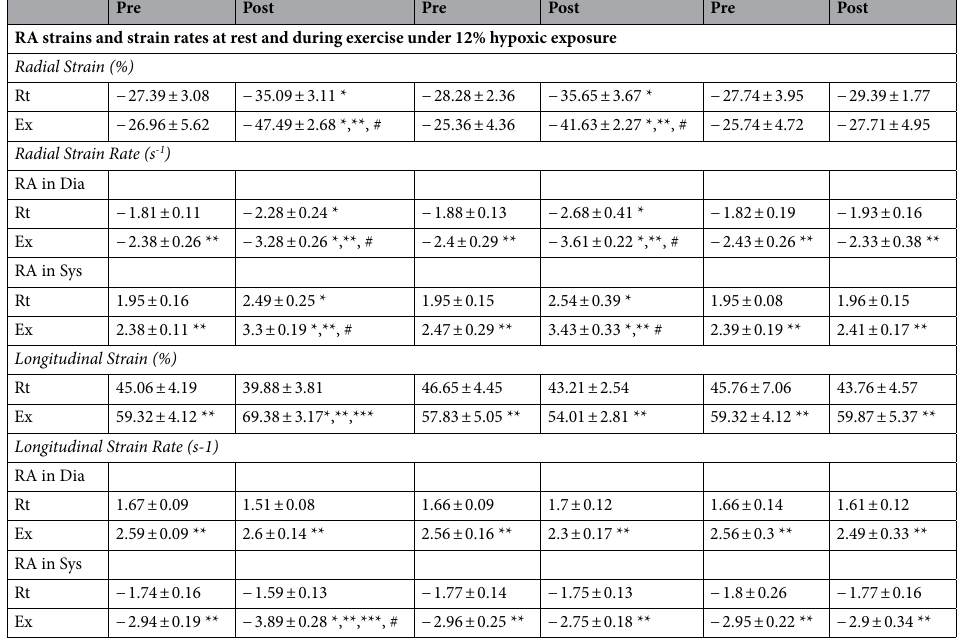
Table 3. The effects of interval and continuous exercise regimens on RA mechanics in HE . Values were mean ± SEM. Values were mean ± SEM. RA in Dia, when RV in the systolic phase; RA in Sys, when RV in the diastolic phase. HIIT, high-intensity interval training group; MICT, moderate-intensity continuous training group; CTL, control group; Rt, at rest; Ex, during exercise; Post, postintervention; Pre, preintervention. *P < 0.05, Pre- vs Post-; **P < 0.05, Rt vs Ex; ***P < 0.05, HIIT vs MICT; # p < 0.05, HIIT or MICT vs CTL.